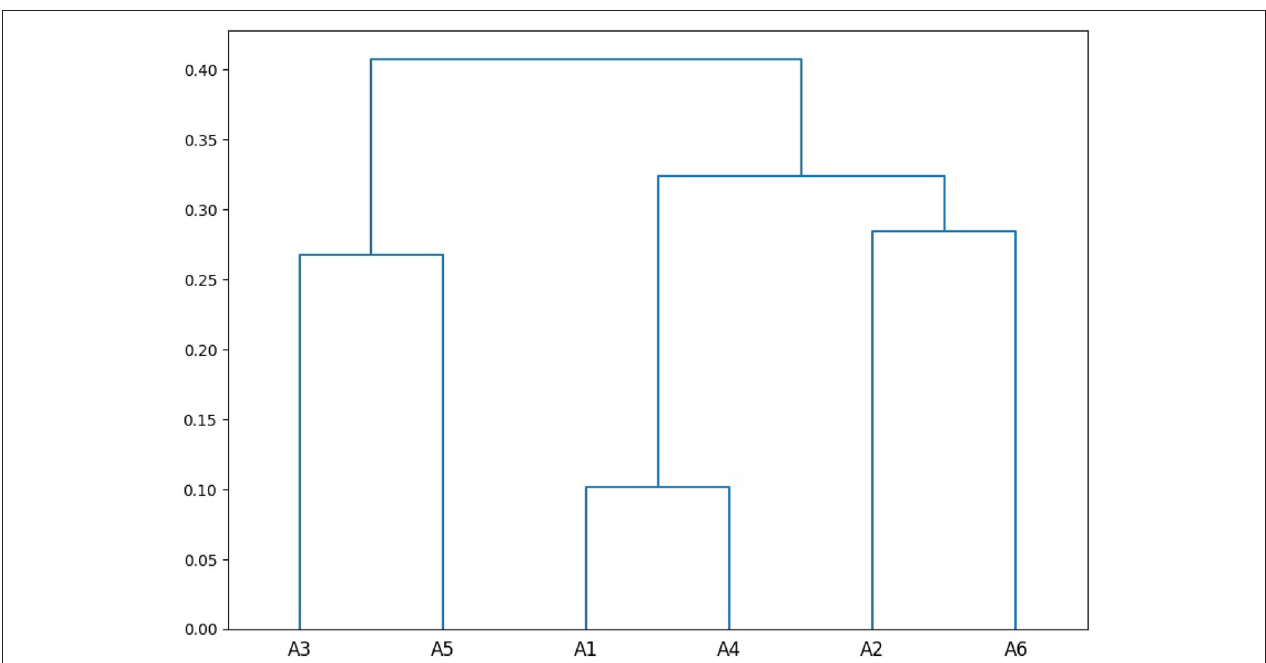
FIGURE 2 | Clustering of annotators using the pairwise disagreement (1 − α ) on the training set.